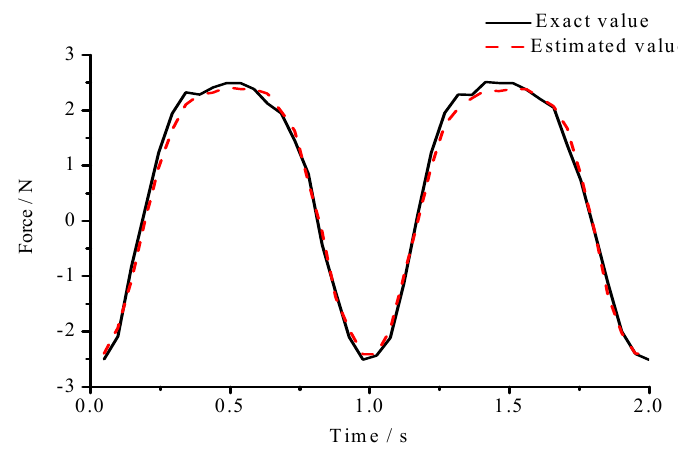
Figure 15. Experiment results of input estimation.